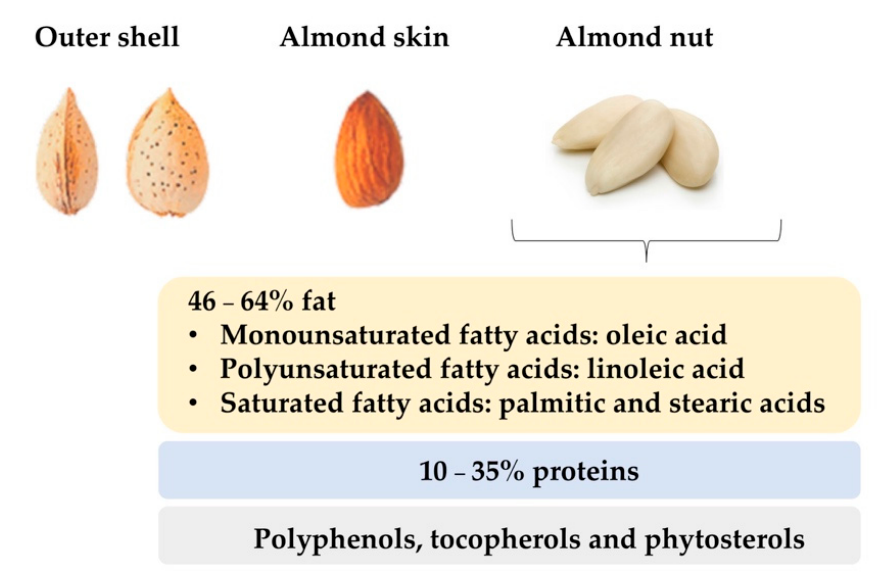
Figure 2. Physical and nutritional characteristics of almond nut.